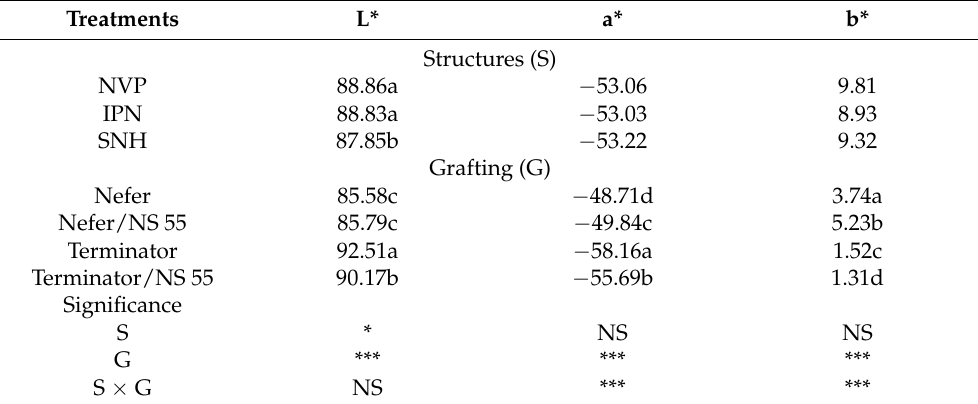
Table 5. Effect of structures and graft combinations on fruit colour determinants.